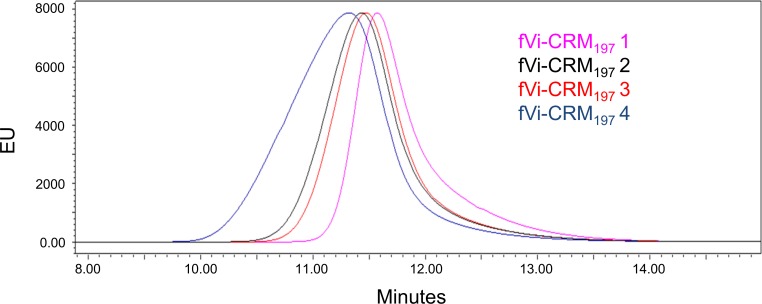
HPLC-SEC profiles (fluorescence emission detection) on TSK gel 3000 PWxl column (NaH2PO4 100 mM, NaCl 100 mM, 5% CH3CN pH 7.2; 0.5mL/min) of fVi-CRM197 conjugates 1 (pink), 2 (black), 3 (red) and 4 (blue) (Table 2).